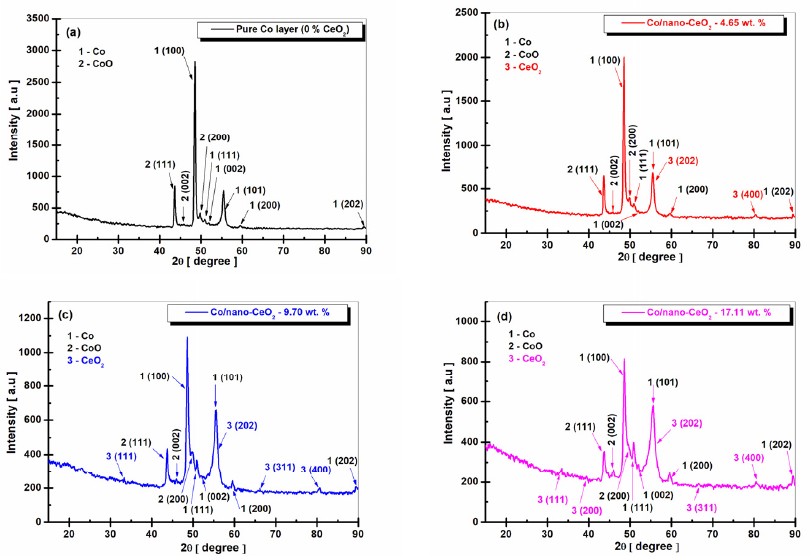
Figure 4. XRD patterns of electrodeposited layers obtained at a current density of 48 mA cm − 2 : ( a ) pure Co layer (0 wt. % CeO 2 ), ( b ) Co/nano-CeO 2 —10 g/L layer (4.65 wt. % CeO 2 ), ( c ) Co/nano-CeO 2 —20 g/L layer (9.70 wt. % CeO 2 ), and ( d ) Co/nano-CeO 2 —30 g/L layer (17.11 wt. % CeO 2 ).